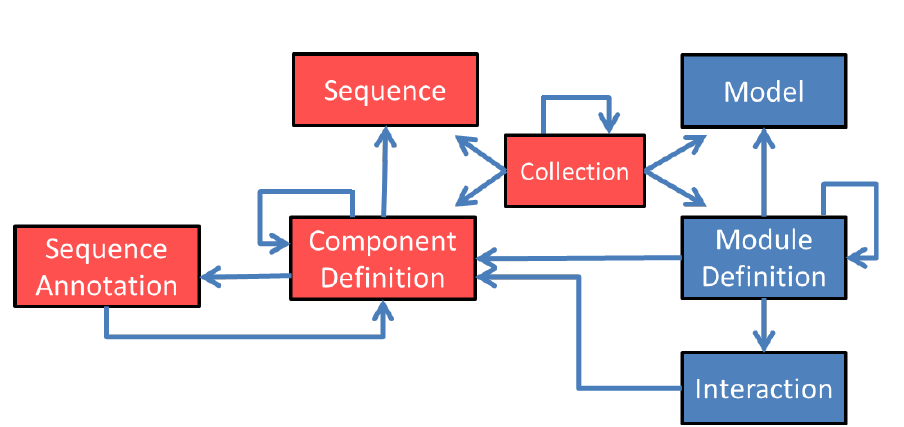
Figure 2: Main classes of information represented by the SBOL standard, and their relationships. Red boxes are classes from the SBOL 1.1 that focused on structure, whereas blue classes are some of the new classes that support the functional aspects of designs.